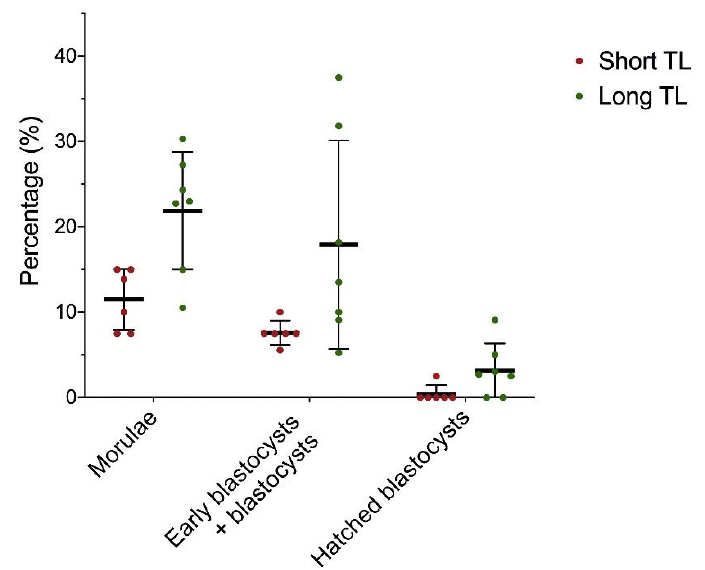
Figure 3. Percentages of morulae, early blastocysts/blastocysts, and hatching/hatched blastocysts at